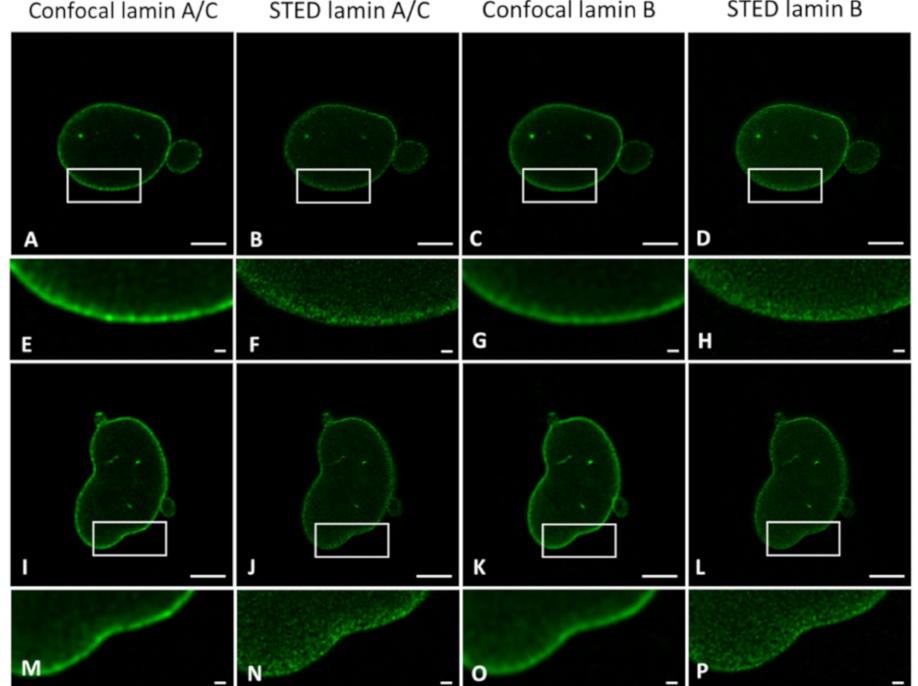
Figure 9. Comparison of confocal ( A , C , I , K ) and STED ( B , D , J , L ) microscopy images of laminopathy patient dermal fibroblasts with an LMNA c.1130G>T (p.(Arg377Leu)) variant, stained with antibodies against lamin A/C ( A , B , I , J ) and lamin B1 ( C , D , K , L ). ( E – H ) Higher magnification (3.1 × ) of ROIs in ( A – D ). ( M – P ) Higher magnification (3.1 × ) of ROIs in ( I – L ). Scale bars: 5 µ